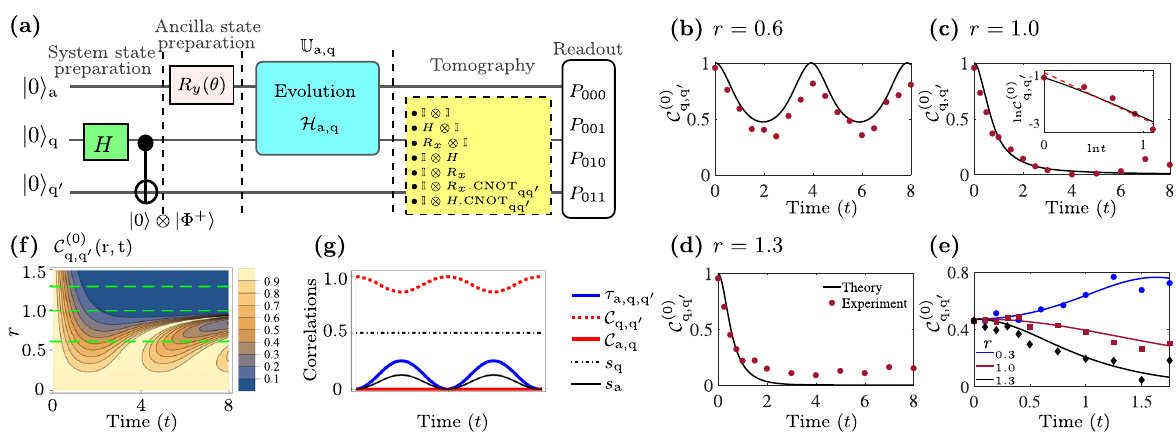
Fig. 3 Demonstration of an apparent violation of entanglement monotonicity. a Quantum circuit implemented on the superconducting quantum processor, where the qubit a serves as ancilla and q and q 0 form a qubit – qubit bipartite system. In b – d we present the results from the experiments, where the variation of concurrence with time is shown for different values of r , with each experiment being repeated 8192 times. Experimental data (red dots) very closely follow the theoretically expected behavior (continuous black lines). The inset in c presents the variation of the logarithm of concurrence versus lnt in the interval t ∈ [1, 3], where the dashed red line is a linear fi t to the experimental red circles. e We prepare the qubits q and q ′ in a state with concurrence 0.475 and we evolve the system under the local non-Hermitian evolution with up to t = 1.75, for different values of r . Solid blue, red, and black curves present the theoretically expected results, while blue circle, red square, and black diamond markers correspond to the respective experimental measurements. In f we show the theoretical plots for the variation of concurrence with time, with one of the qubits undergoing a local non-Hermitian evolution, for various parameters r ∈ [0, 1.5]; the horizontal green lines mark the values of r corresponding to the experimental results in panels ( b – d ). The correlations among the system qubits and ancilla, simulated based on the quantum circuit in a are presented in g for r = 0.6, where the concurrence between the system qubits and between the system qubit and ancilla are shown with dotted and continuous red lines, respectively, the dot-dashed and continuous black lines present the linear entropy of the system qubit and of the ancilla, and the continuous blue line corresponds to the three-tangle